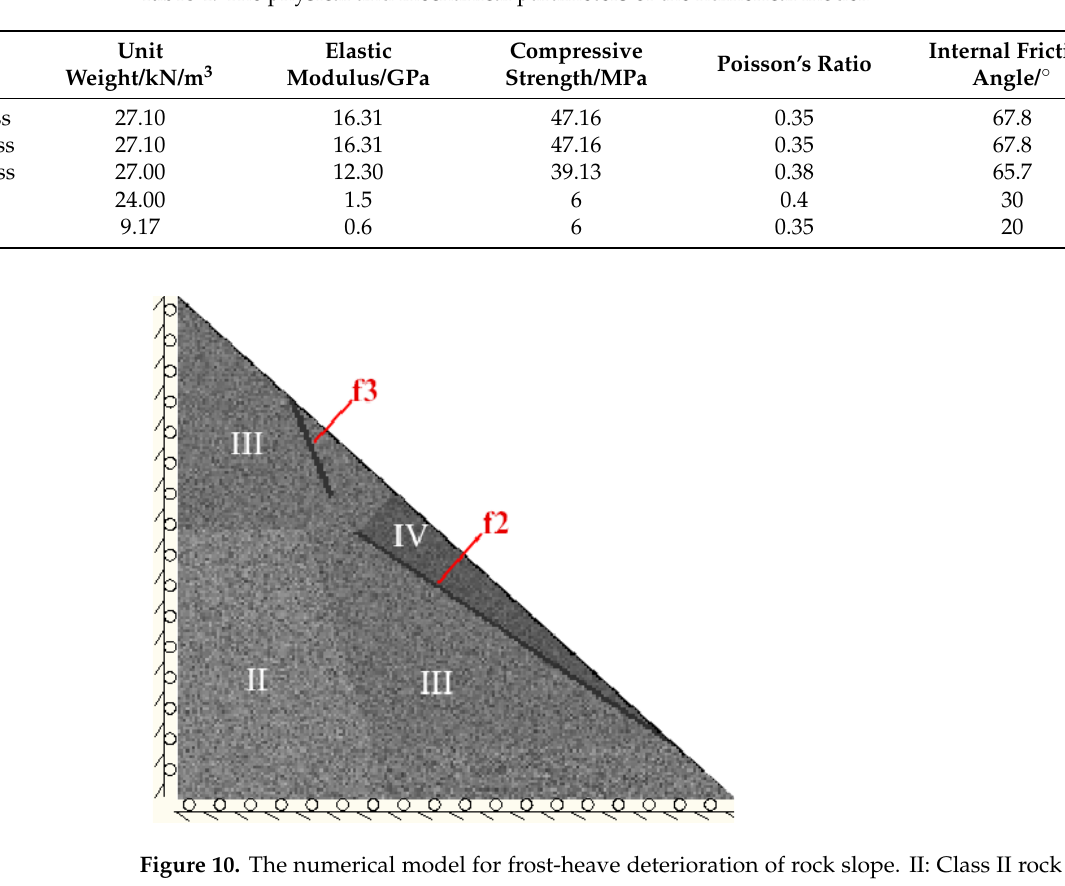
Table 4. The physical and mechanical parameters of the numerical model. Table 5. The physical and mechanical parameters of the slope numerical